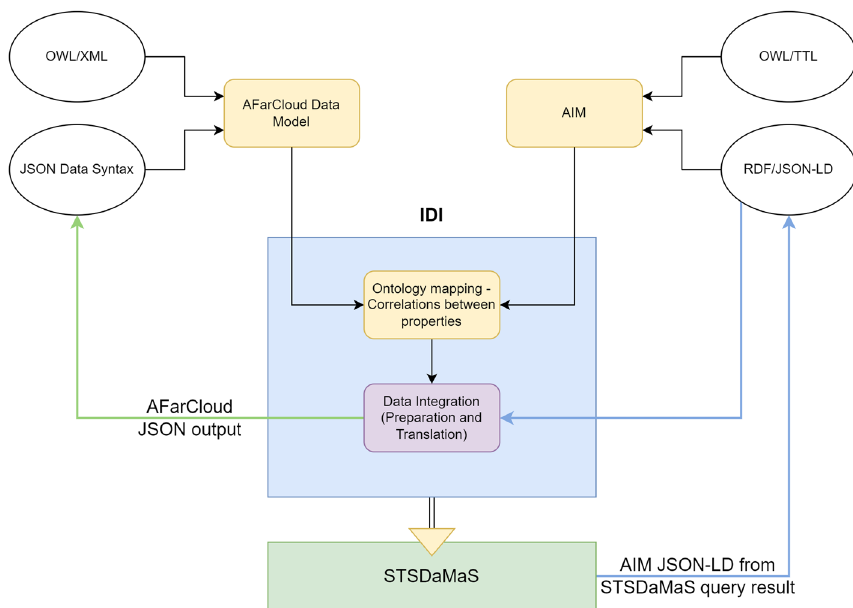
Fig. 5 Interoperability through Data Integration (IDI). AFarCloud Use Case